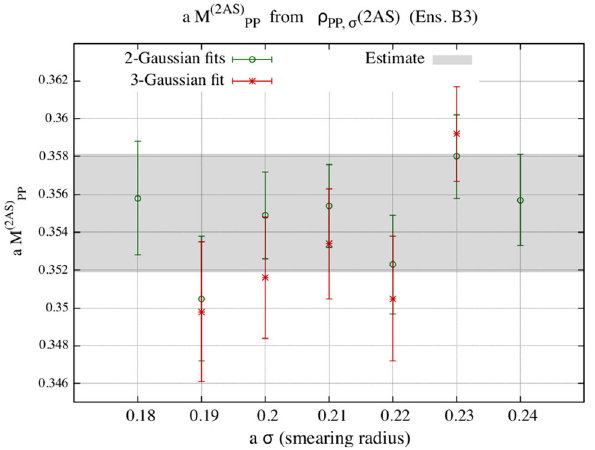
Fig. 13 Fit results for aM ( 2AS ) from the ensemble B3, obtained from PP two (green) and three (red) Gaussian fits of smeared spectral densities at differentsmearingradii σ. Fluctuationatdifferentvaluesofthesmearing radius translate into a systematic component of the uncertainty. This is summedinquadraturetothestatisticalerrorinthegray,horizontalband, ( 2AS ) = 0 . 3550 ( 31 ) the estimate for the pseudoscalar mass aM PP